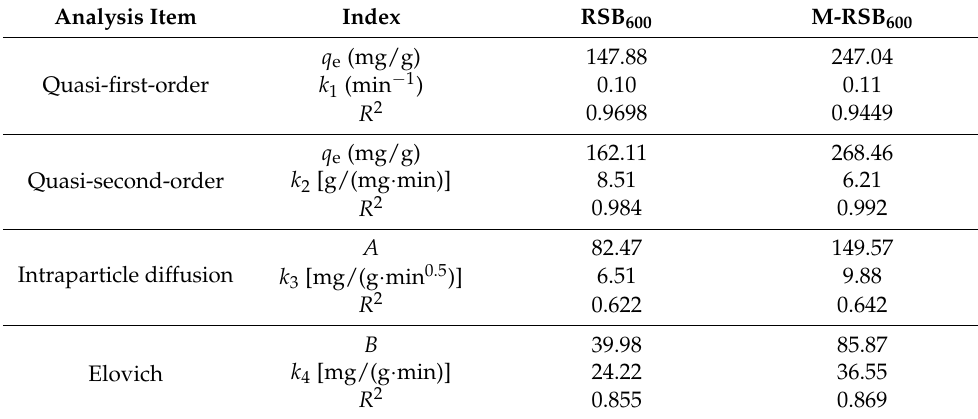
Figure 9. Adsorption kinetics fitting of RSB 600 and M-RSB 600 for MB: ( a ) quasi-first-order kinetic model, ( b ) quasi-second-order kinetic model, ( c ) intraparticle diffusion model and ( d ) Elovich model. Table 3. Adsorption kinetics fitting parameters of RSB 600 and M-RSB 600 for